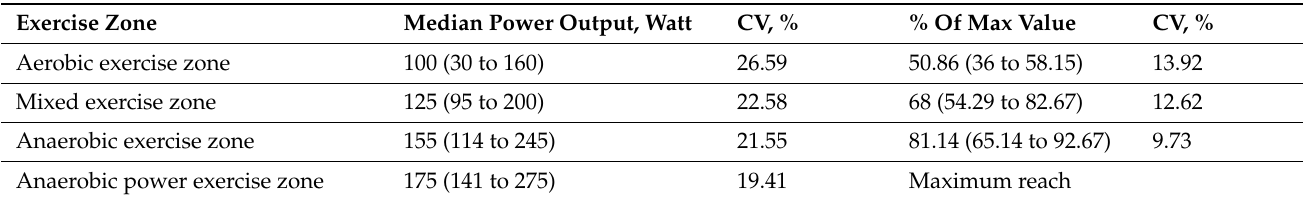
Table 1. Power Output for each exercise zone illustrated as median